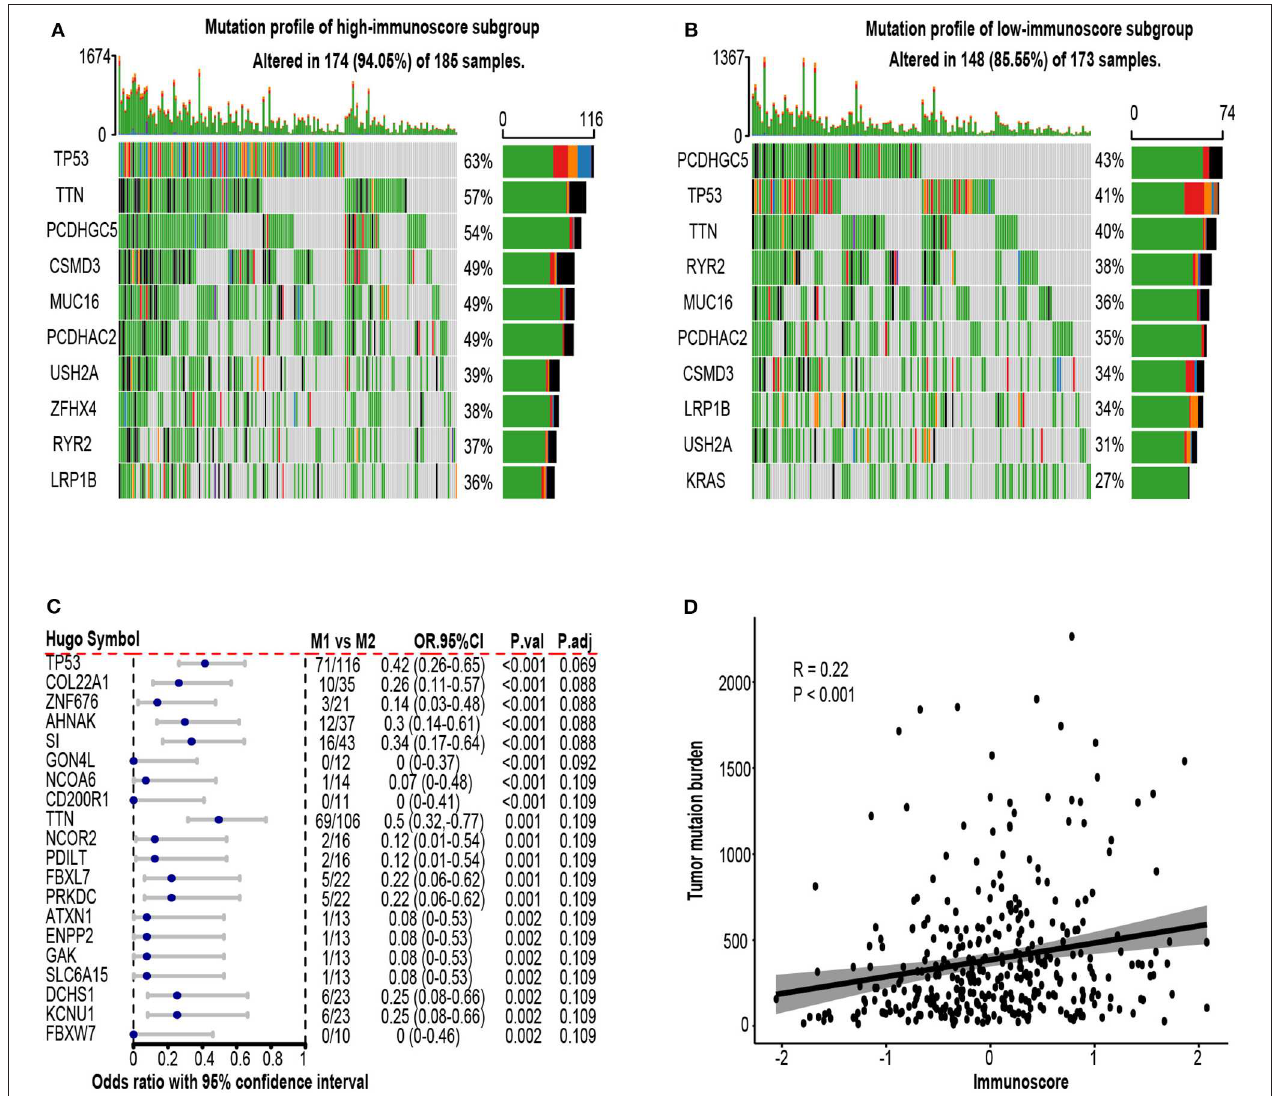
FIGURE 9 | Mutation profile in the TCGA-LUAD cohort. (A) Mutation profile of high-immunoscore subgroup. (B) Mutation profile of low-immunoscore subgroup. (C) Differentially mutated genes between high and low immunoscore patients. (D) Correlation between tumor mutation burden (TMB) and immunoscore. OR.95%CI, odds ratio with 95% confidence interval. P.adj, adjusted P -value by false discovery